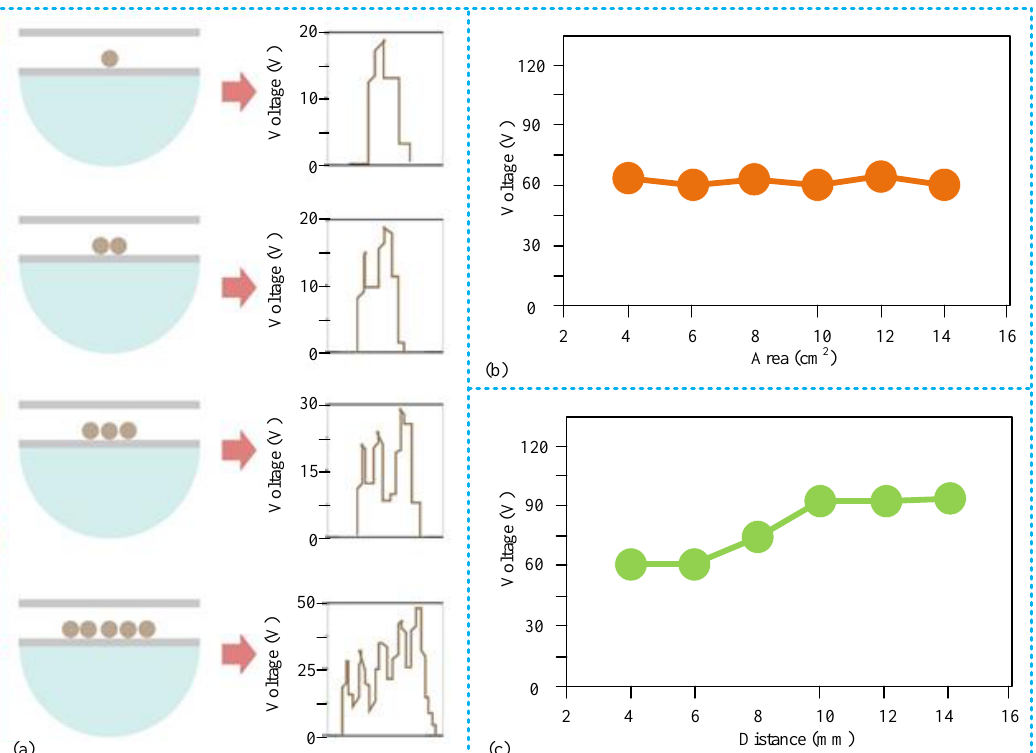
Figure 6. Influence of the internal structure on the output performance of the sensor. ( a ) Effect of the number of PTFE balls on the output voltage and waveform; ( b ) effect of the area of the copper electrode on the output performance of the sensor; and ( c ) effect of the distance of the copper electrode on the output performance.